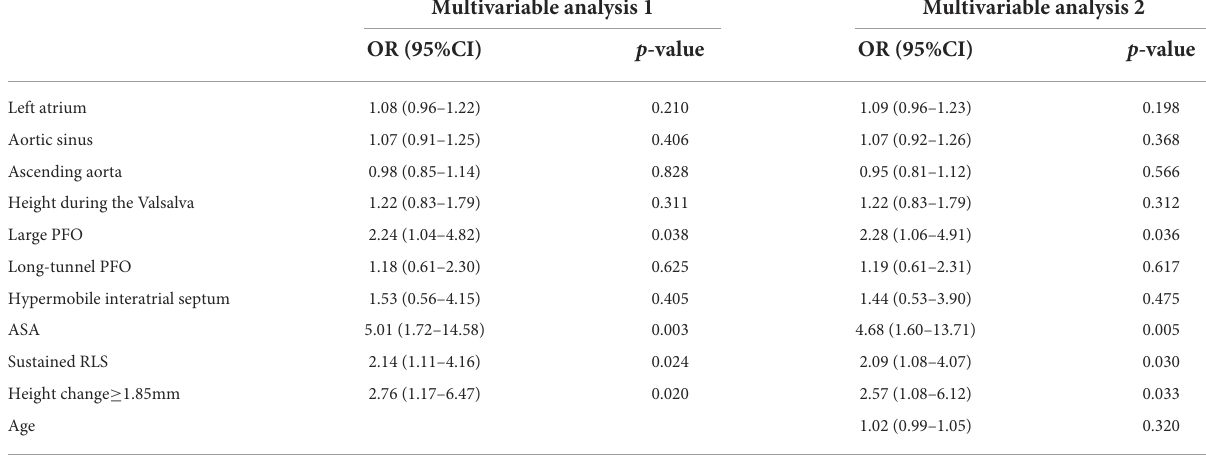
TABLE 4 Multivariable regression logistic analyses based on dichotomous parameters of PFO characteristics.